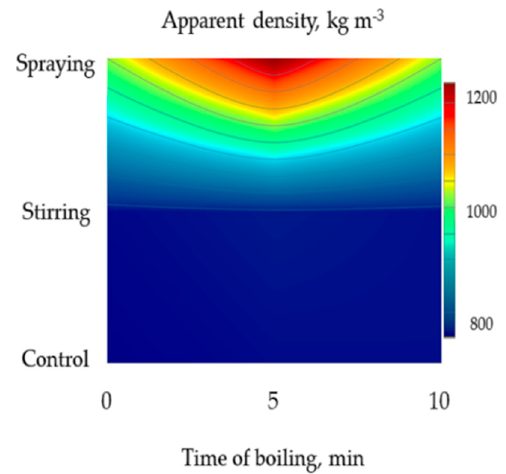
Figure 3. Two-dimensional fuzzy contour plotting for the interactive effect of time of boiling and method of addition on the apparent density of non-wood pellets from pressing residual biomass from distillation of cellulosic bioethanol with liquid-state food waste.